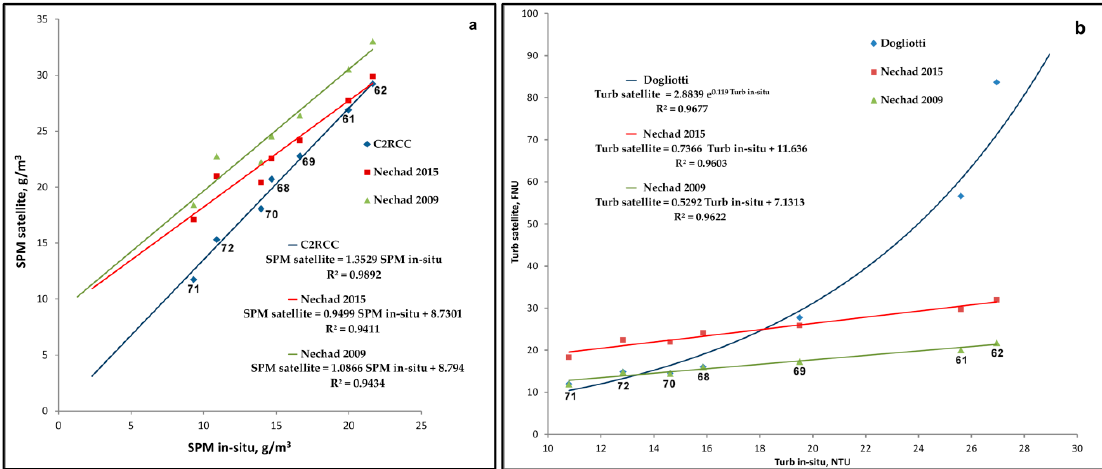
Figure 12. Performance of different satellite retrieval algorithms compared with in situ measurements: ( a ) SPM satellite vs. SPM in situ; ( b ) satellite turbidity (Turb satellite) vs. in situ turbidity obtained with PT (Turb in situ). The station numbers are indicated beside the marks.